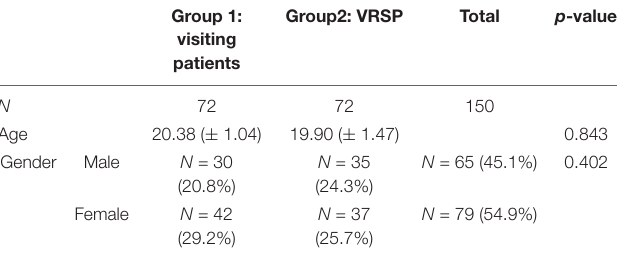
TABLE 1 | Demographic characteristics of participants.